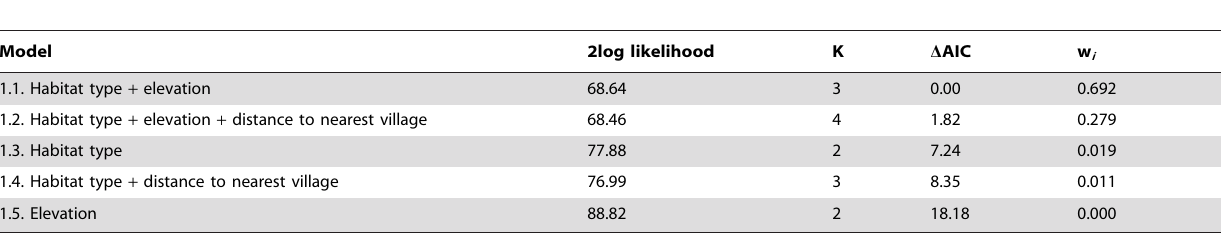
Table 1. Best logistic regression models explaining the relationship between habitat use and the presence or absence of crop- raiding by